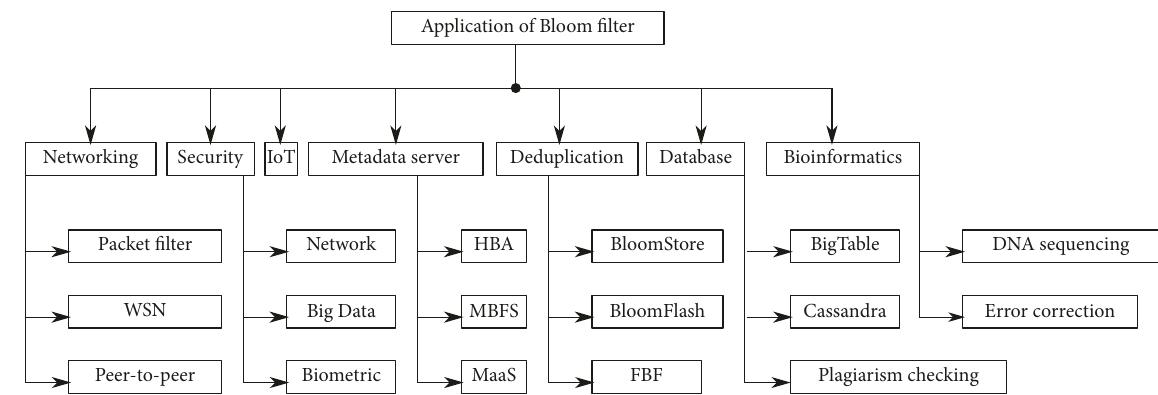
Figure 5: Application of Bloom filter in prominent